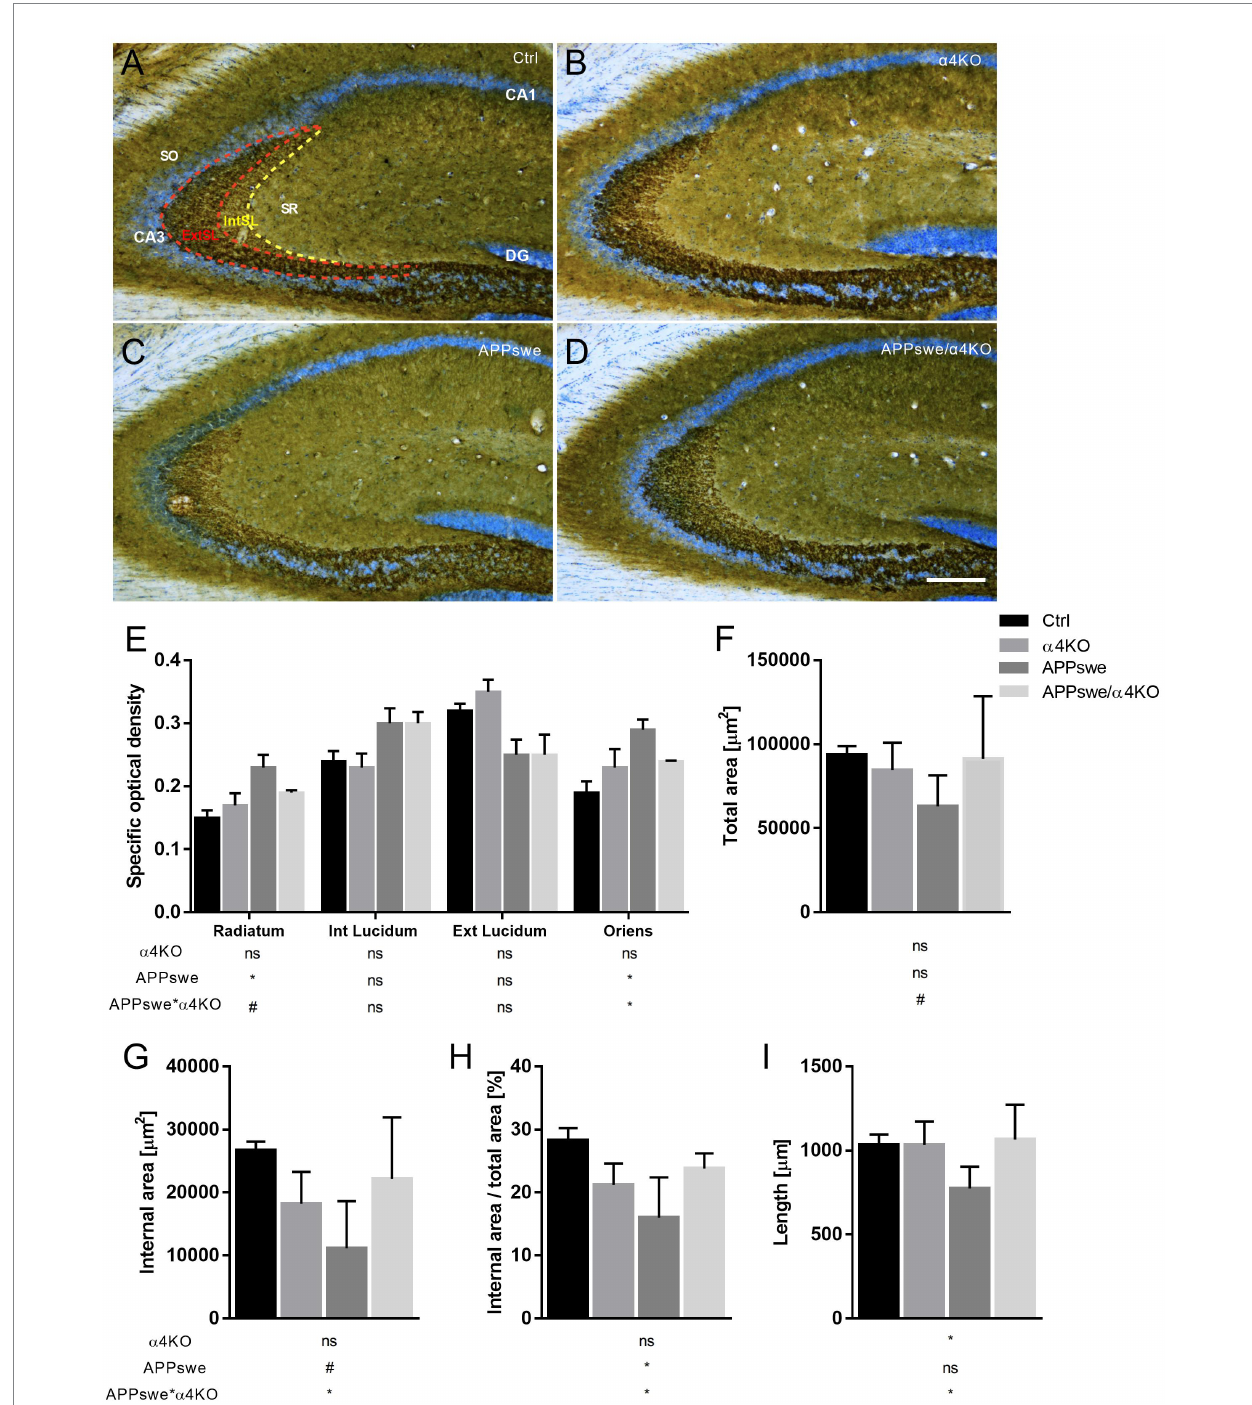
FIGURE 4 Quantitative analysis of SYN immunoreactivity in hippocampal CA3 field of 15 mo mice. (A–D) Representative images of SYN ir in the CA3 field of 15 mo Ctrl (A) , α 4KO (B) , APPswe (C) , and APPswe/ α 4KO (D) mice. Scale bar: 200 μ m. (E–I) Densitometric analysis of SYN ir in hippocampal stratum radiatum, internal (dashed yellow line) and external (dashed red line) stratum lucidum and stratum oriens of CA3 field by analyzing specific optical area (E) , total area (F) , internal area (G) , internal area/total area (H) , and length (I) . Data are shown as mean ± SEM and compared by two-way ANOVA test, * p < 0.05, # 0.10 > p > 0.05 as trend for a significant difference. SR, Stratum Radiatum; SL, Stratum Lucidum; IntSL, internal SL; ExtSL, external SL; SO, Stratum